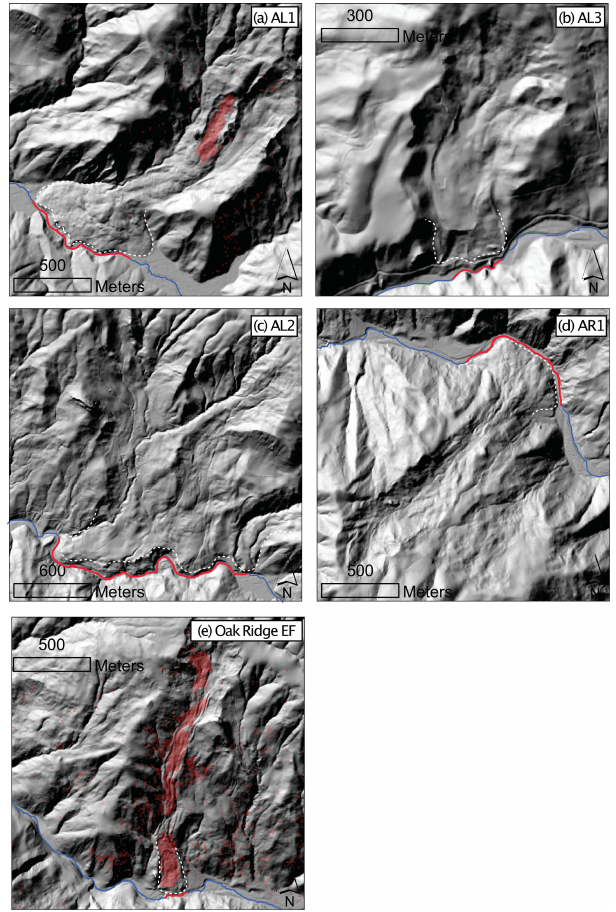
Figure 3. Shaded relief maps of three large earthflows on Alameda Creek (a–c) and two on Arroyo Hondo (d–e) . Dashed white lines indicate the mapped edge of earthflow toes, and red lines indicate where river channels (shown in blue) intersect earthflows. Areas of red shading show regions where the InSAR analysis indicated line- of-site velocities in excess of 3cmyr − 1 .